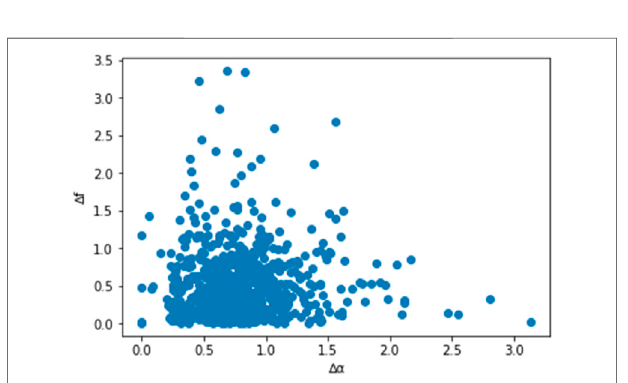
FIGURE 4 | Scatter diagram of Δα ~ Δ f